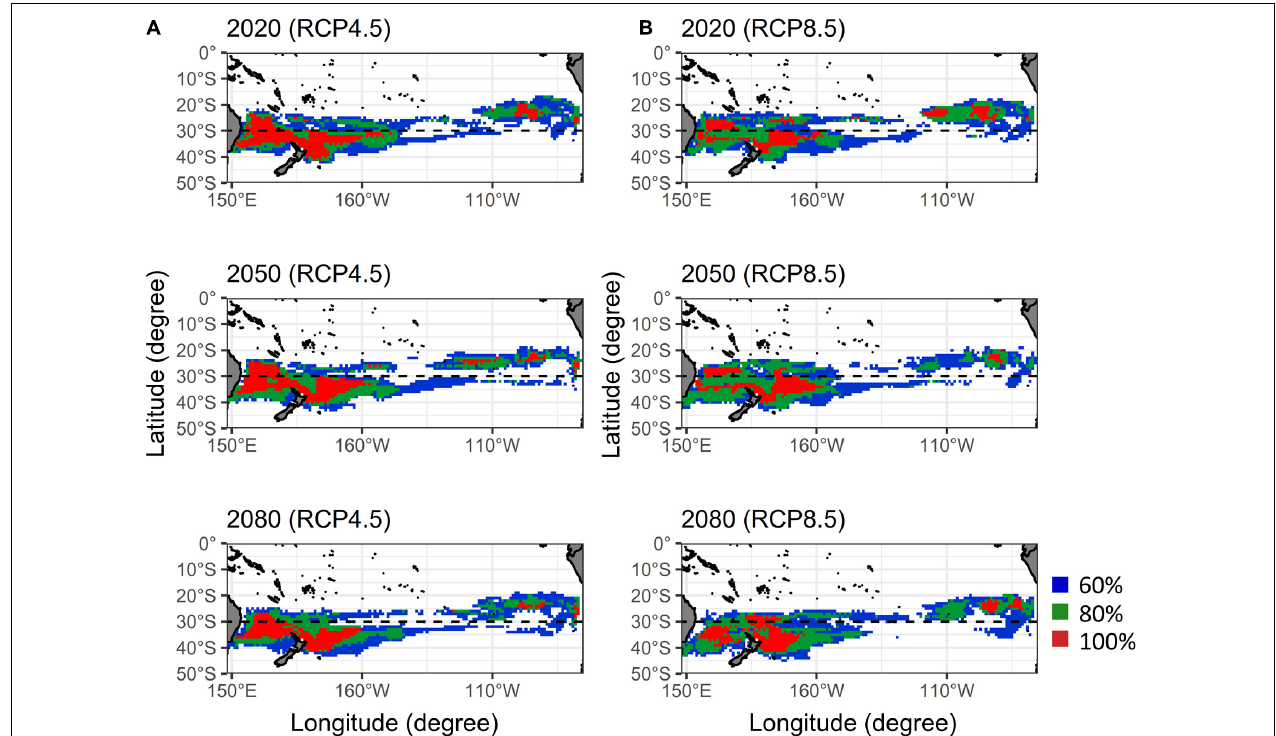
FIGURE 5 | Ensemble agreement maps of the south Pacific albacore habitat predictions by five atmosphere-ocean general circulation models (AOGCMs) for the current (2020), mid (2050), and late (2080) periods of the twenty-first century under the (A) RCP 4.5 and (B) RCP 8.5 (right panel) scenarios. Colors denote the probabilities of habitat map based on the levels of agreement among five AOGCMs.